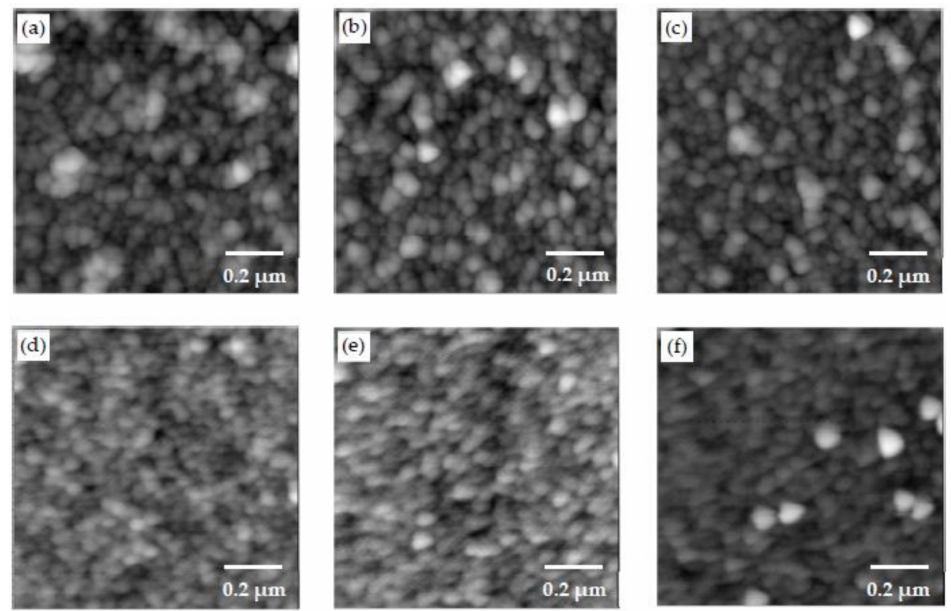
Figure 6. AFM images showing the morphology of ( a – c ) PEI/PSS-CSH(10), PEI/PSS-CSH and PEI/PSS-CSH(40), respectively. AFM images showing the morphology of ( d – f ) PDDA/PAA-CSH(10), PDDA/PAA-CSH and PDDA/PAA-CSH(40), respectively.